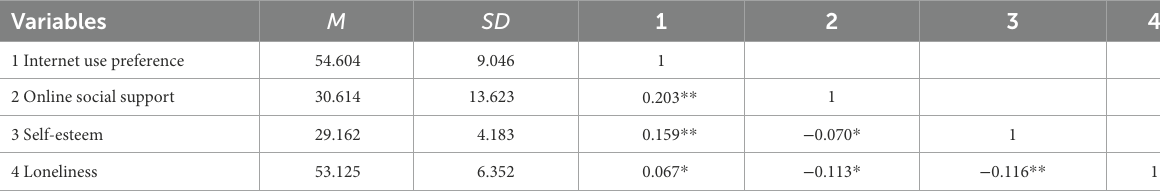
TABLE 1 Correlations among variables, means, and standard deviations. Variables